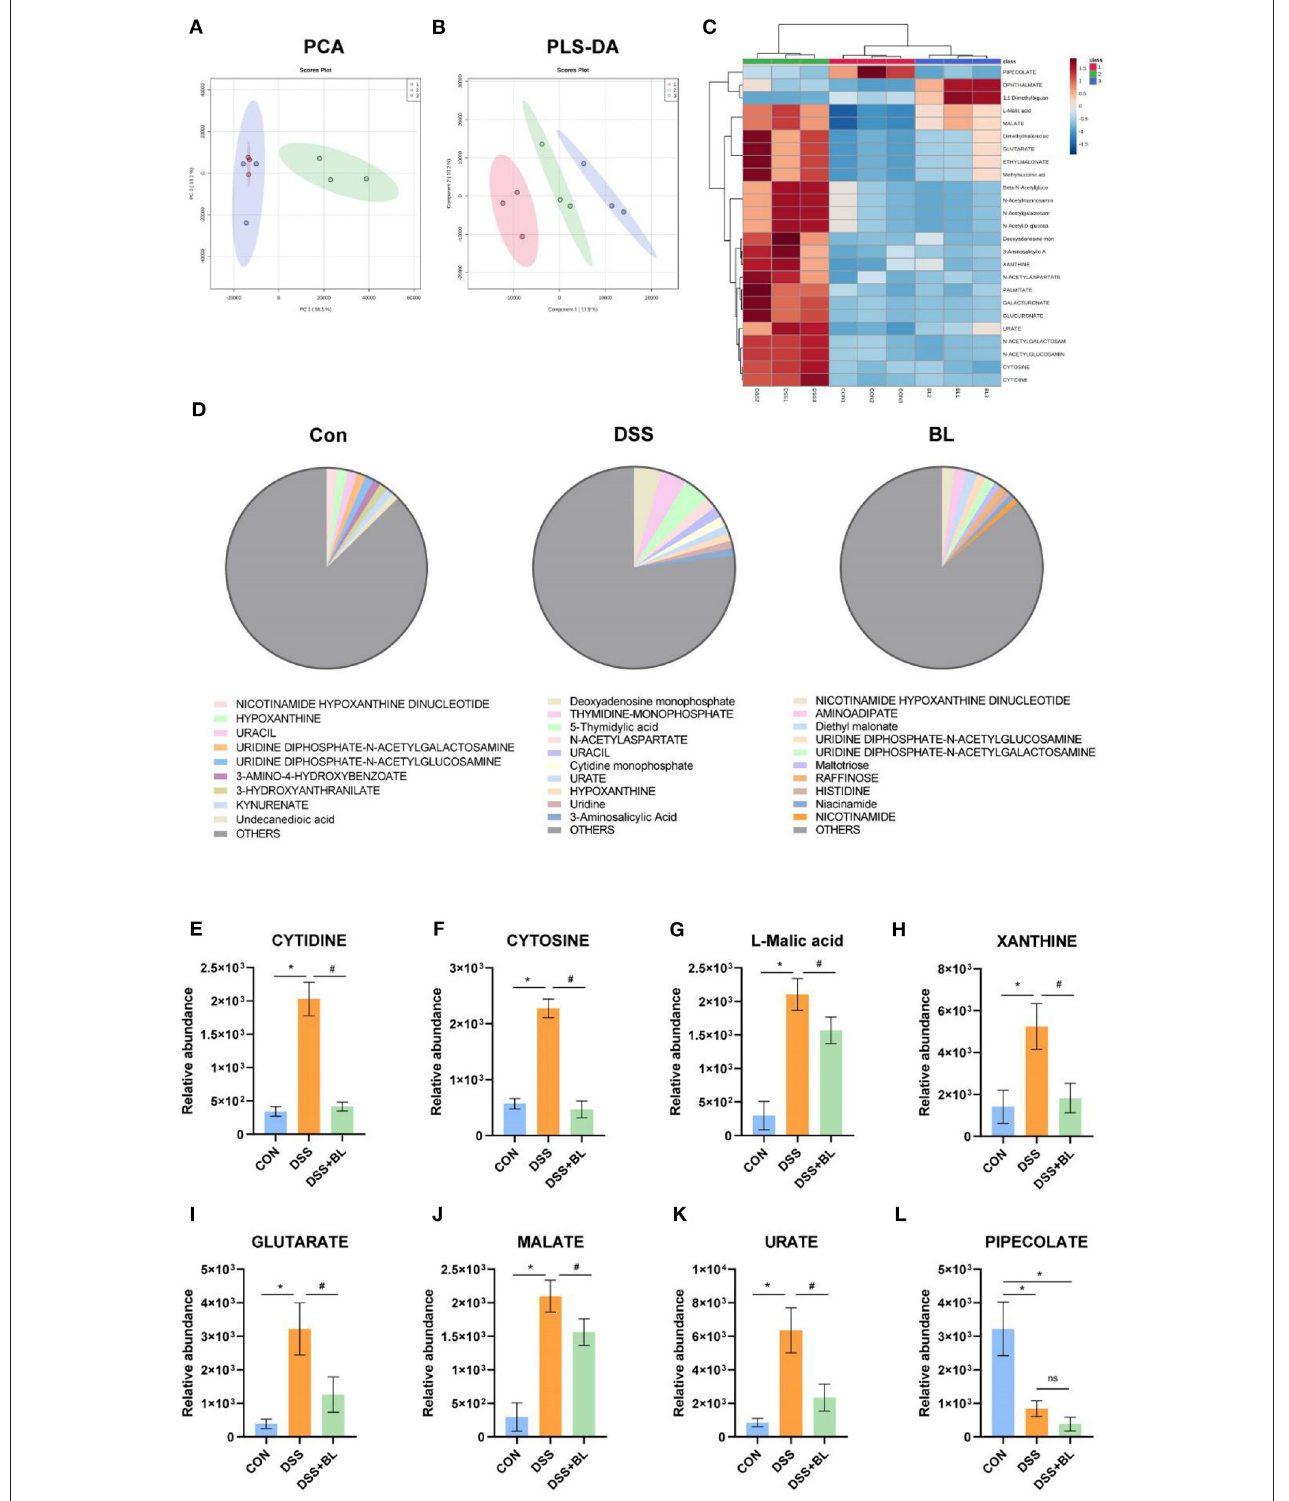
FIGURE 4 | Effects of bovine lactoferrin (BL) on gut microbial metabolites in dextran sulfate sodium salt (DSS) mice. (A) Principal component analysis (PCA) of intestinal flora metabolites. (B) Partial least squares discriminant analysis (PLS-DA) of intestinal flora metabolites. (C) Top 25 common metabolites. (D) Proportion of top 10 metabolites in each group. (E–L) Relative abundance of top eight metabolites. One-way ANOVA was used to compare the three groups. * P < 0.05 vs. control; # P < 0.05 vs. DSS.